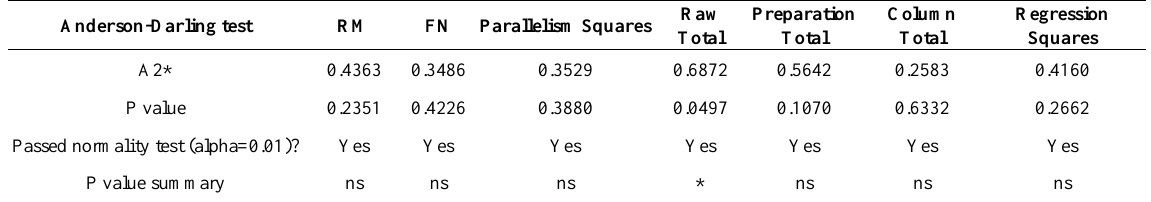
Raw Preparation Column Regression Total Total Total Squares